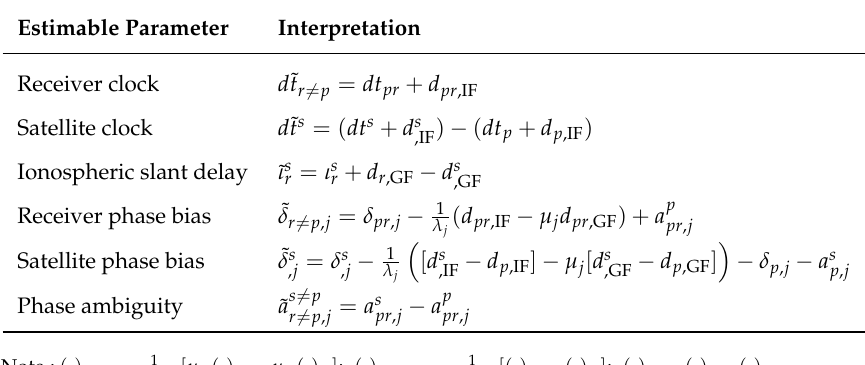
Table 1. Estimable dual-frequency PPP-RTK network parameters and their interpretation using the Common Clocks S -system (the symbol p denotes the pivot satellite/receiver if it is used as